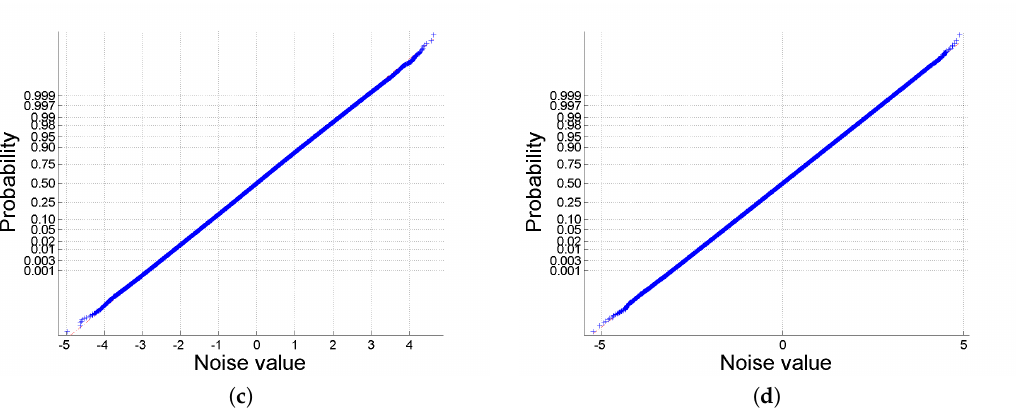
Figure 7. Normal probability plot for the noise: ( a ) before whitening, and whitening after